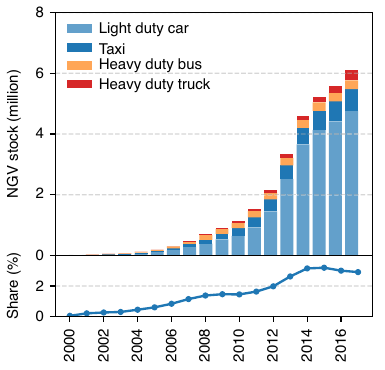
Fig. 1 Population of natural gas vehicles (NGVs) and their share in total vehicle stock in China from 2000 to 2017. Supplementary Table S1 lists the number of NGVs in each category. Source data are provided as a Source Data fi